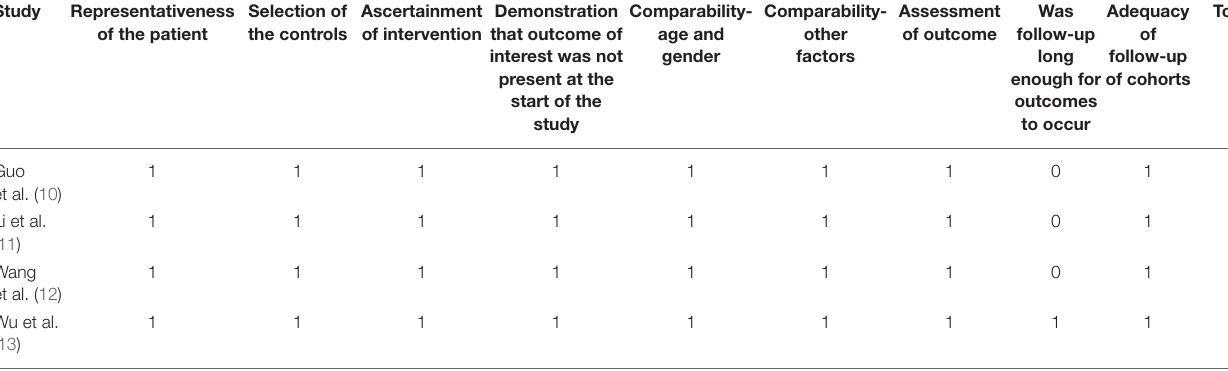
TABLE 2 | Details of study quality evaluation via the Newcastle–Ottawa Scale.